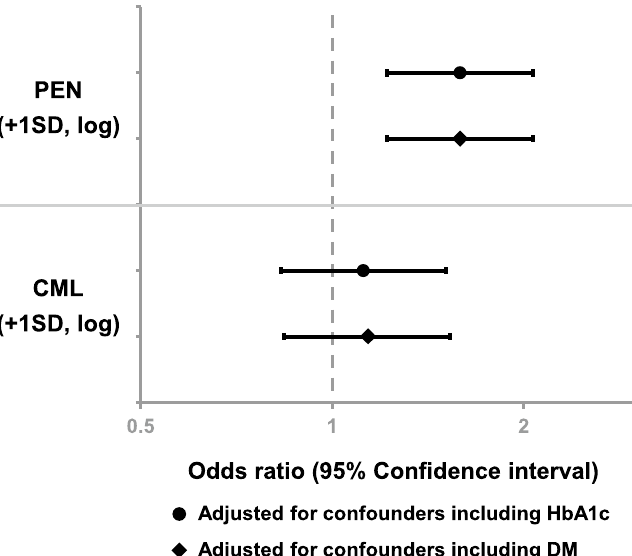
Figure 3. Multiple logistic regression analysis for prevalent vertebral fracture by AGE level. PEN was adjusted for patient age, body height, lumbar BMD, eGFR, homocysteine, NTx, prevalence of hypertension, and HbA1c or prevalence of DM. CML was adjusted for patient age, body height, hip fat, lumbar BMD, albumin, BUN, sclerostin, prevalence of hypertension, and HbA1c or prevalence of DM. AGE advanced glycation end product, PEN pentosidine, BMD bone mineral density, eGFR estimated glomerular filtration rate, NTx cross-linked N-telopeptide of type I collagen, HbA1c hemoglobin A 1c , DM diabetes mellitus, CML carboxymethyl-lysine, BUN blood urea nitrogen, SD standard deviation.